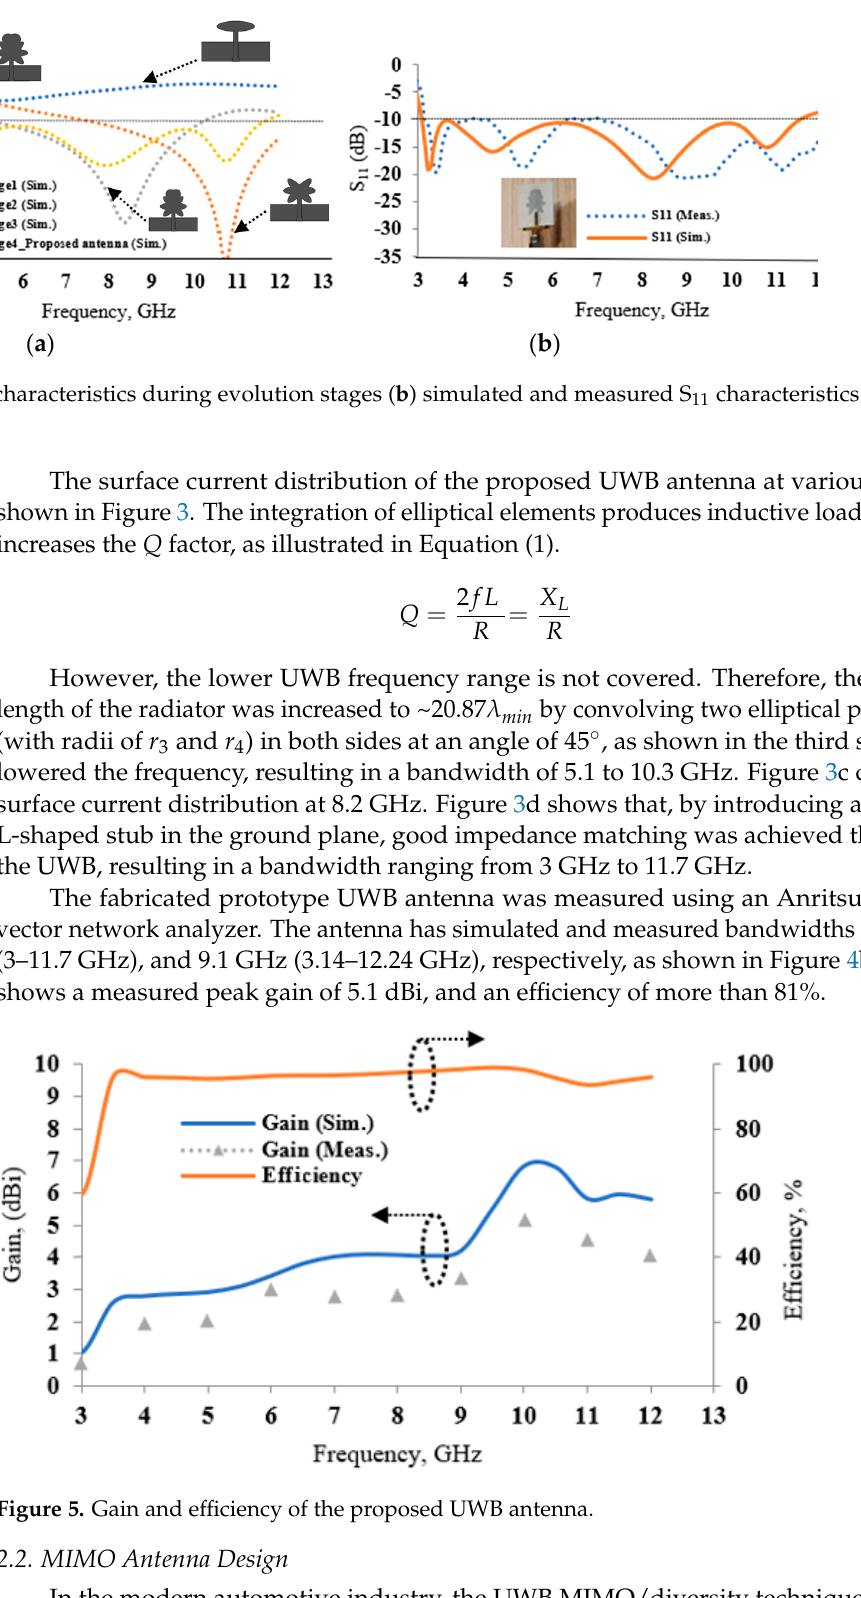
Figure 3. Surface current distribution at different stages of the proposed UWB antenna: ( a ) 5.2 GHz ( b ) 10.7 GHz ( c ) 8.2 GHz, and ( d ) 8 GHz.